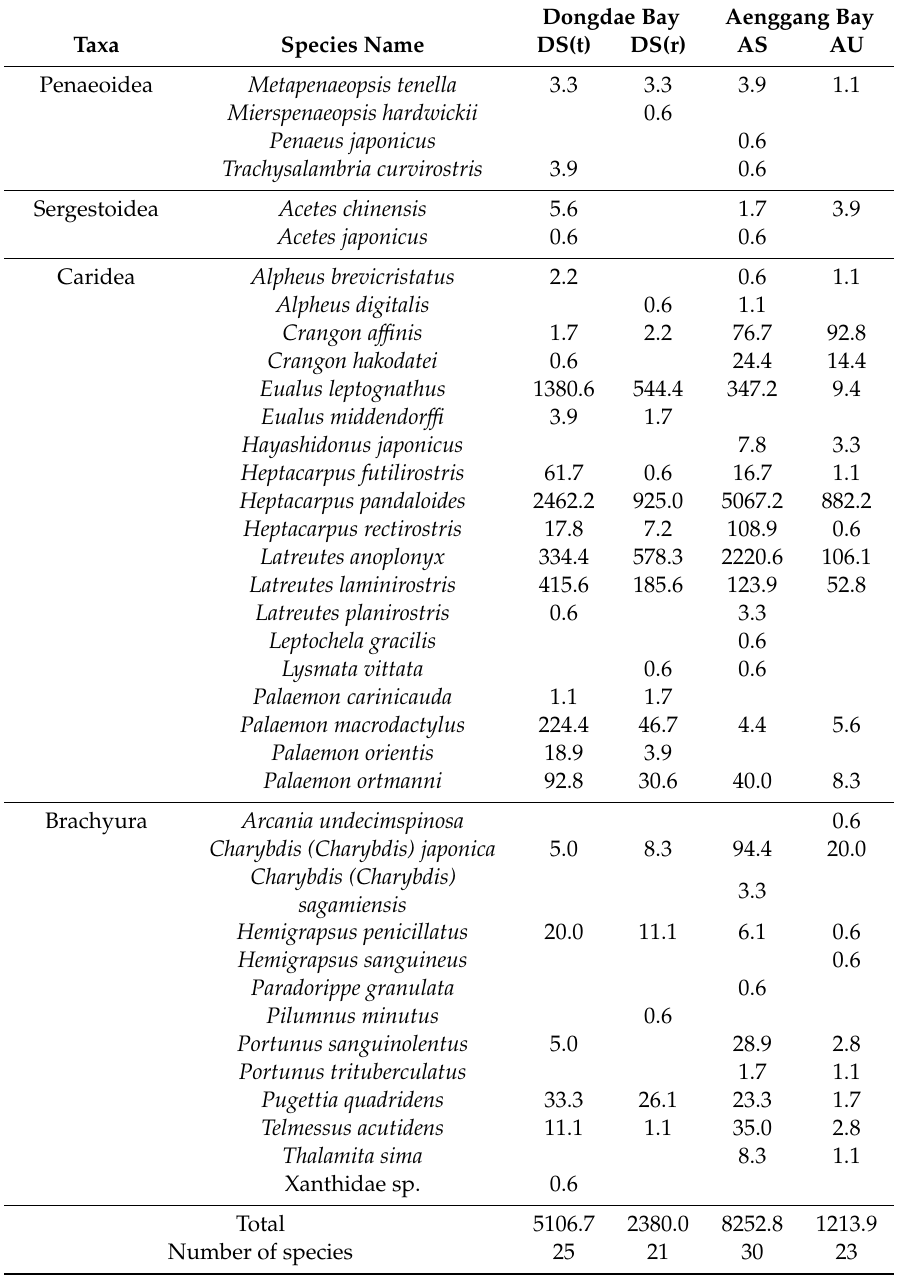
Table 1. Decapod species and total abundance (per 100 m − 2 ) in seagrass beds adjacent to tidal flat (DS(t)) and rocky shore (DS(r)) of Dongdae Bay, seagrass beds (AS) and adjacent habitats to the unvegetated areas (AU) of Aenggang Bay, Namhae Island, South